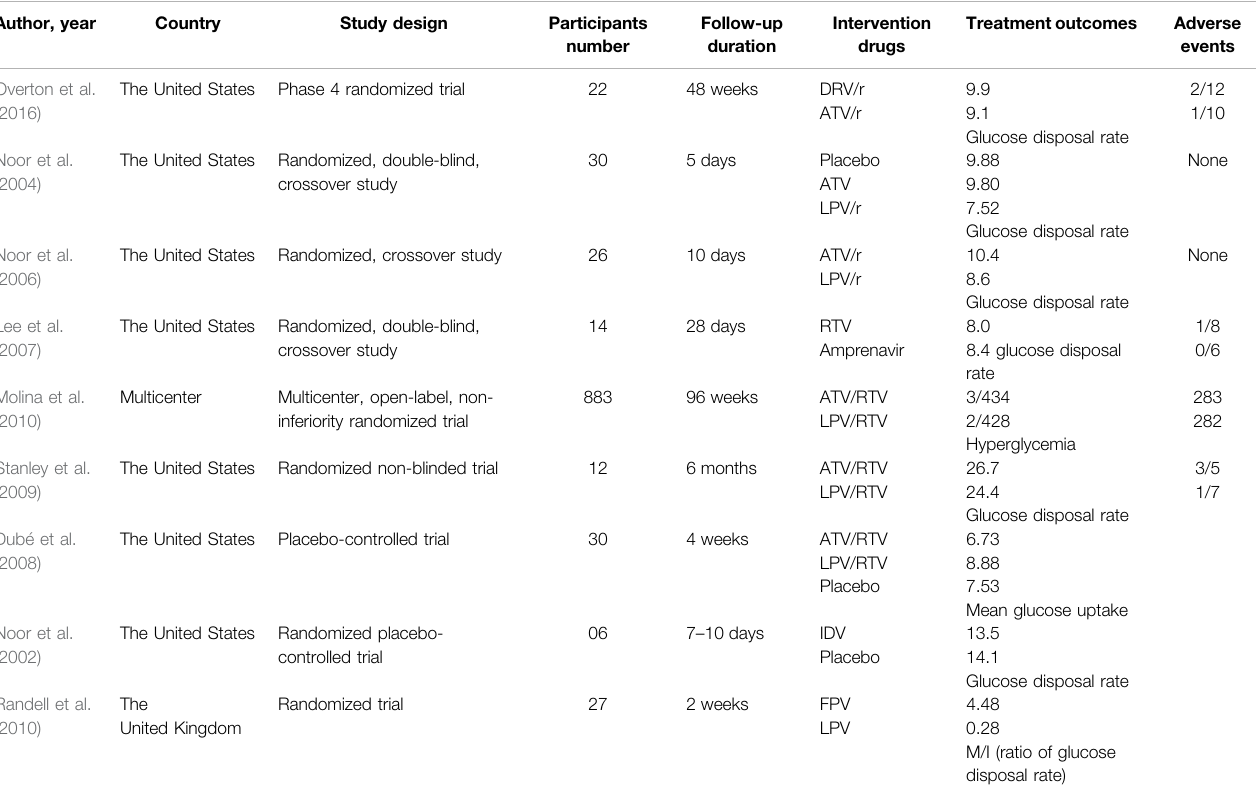
TABLE 1 | Characteristics of included RCTs.